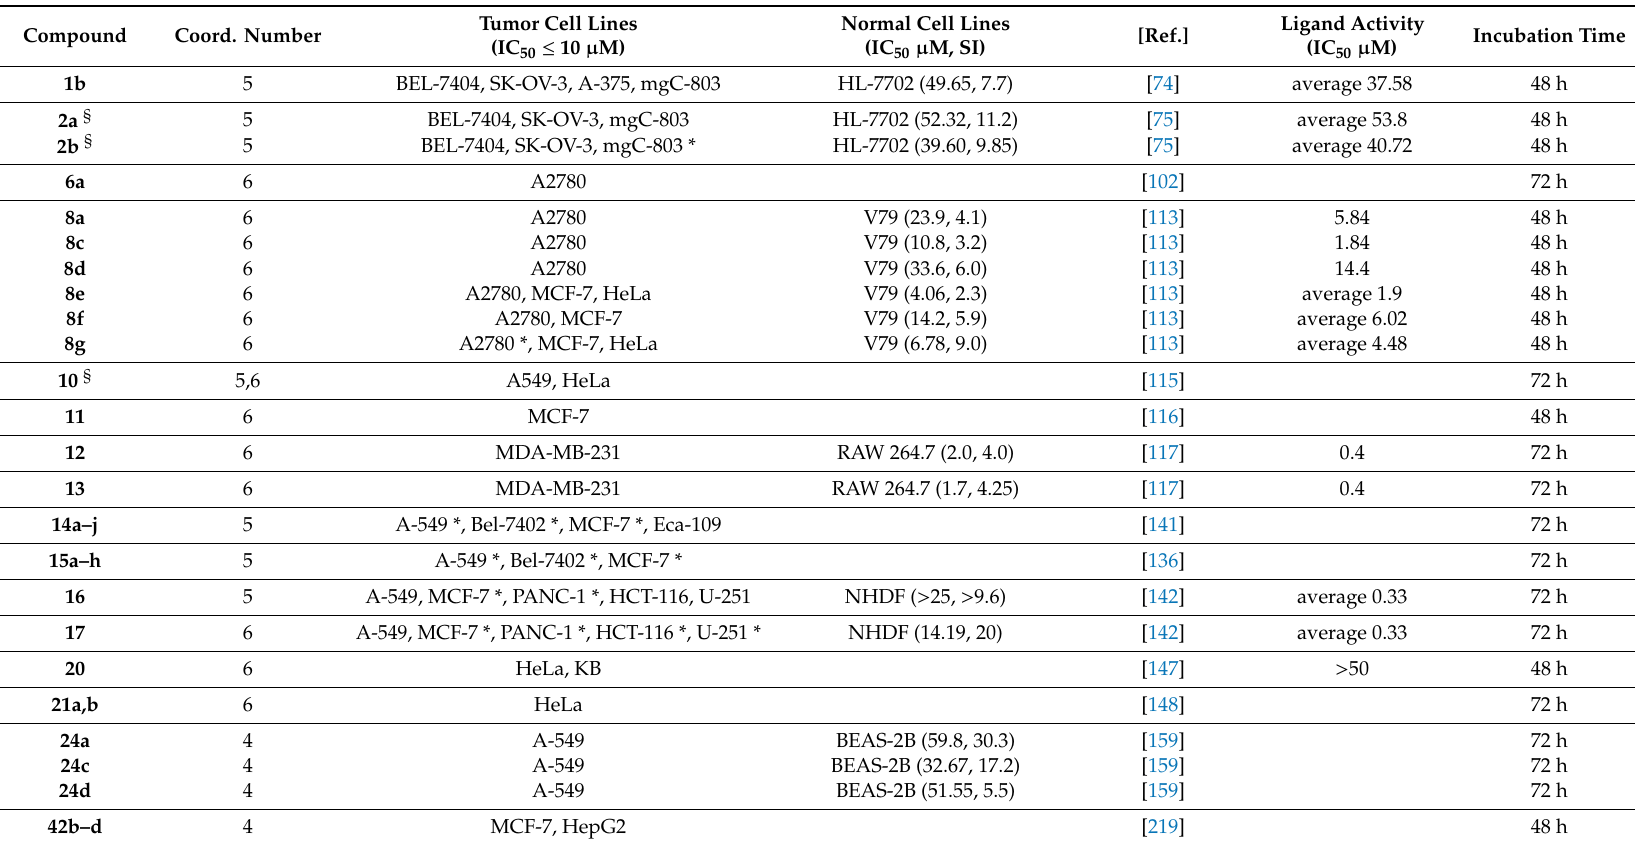
Table 13. Zinc compounds which showed an antiproliferative activity characterized by IC 50 values ≤ 10 µ M.